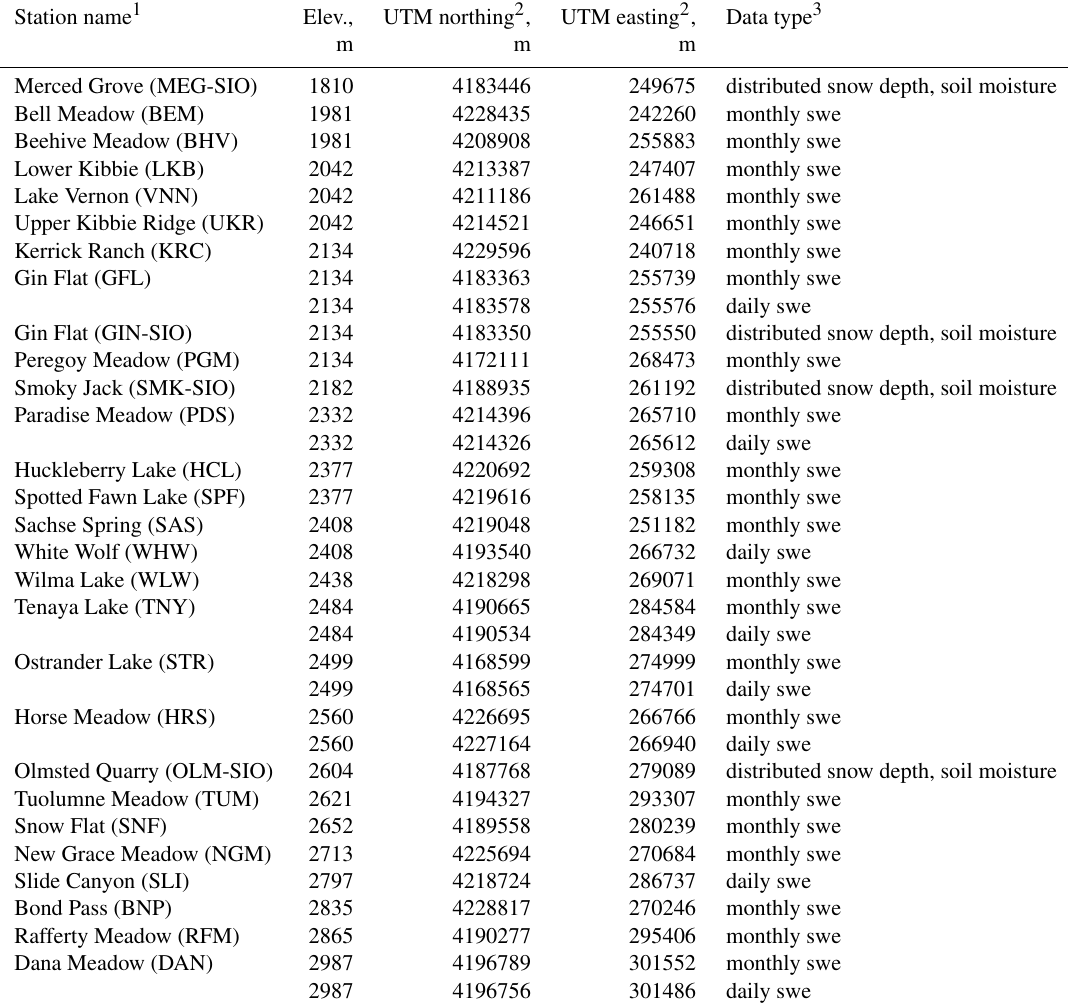
Table 3. Snow and soil moisture data